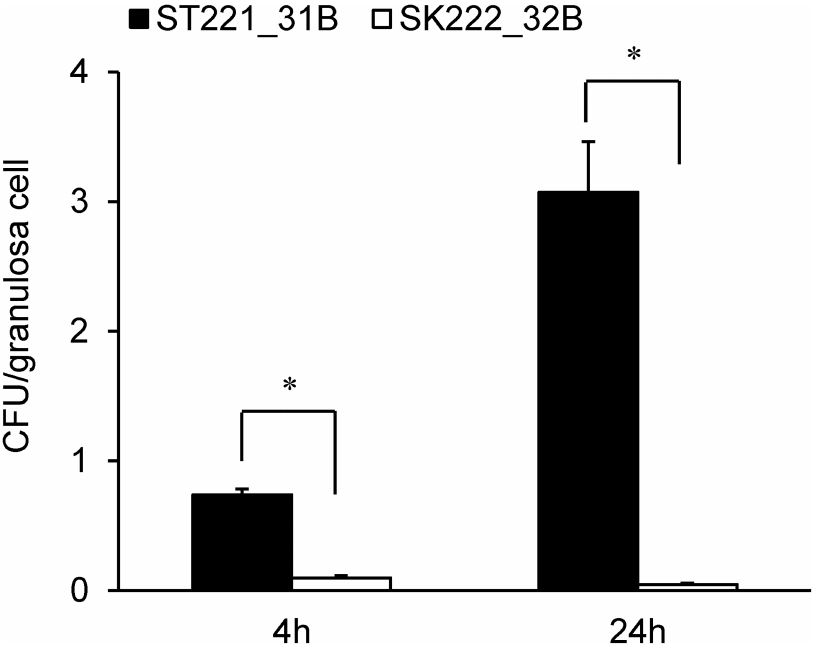
Fig 4. Intracellular survival of Salmonella strains in granulosa cells. ■ ST221_31B, □ SK222_32B. Ovarian granulosa cells were infected with S . Typhimurium (ST221_31B) and S . Kentucky (SK222_32B) at an MOI of 30. * , p < 0.05 by t-test